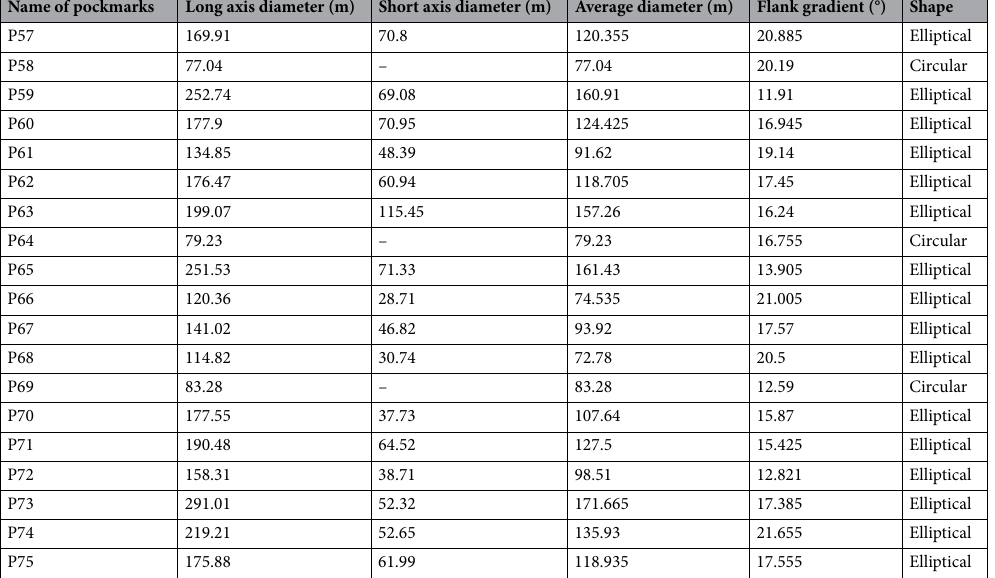
Table 2. Morphometric parameters of the studied pockmarks.